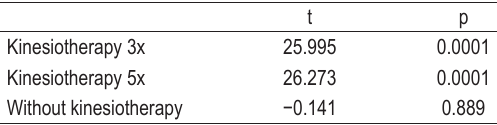
TABLE 5. Comparison of the average values of the oswestry disability index before and after treatment (student t ‑test)